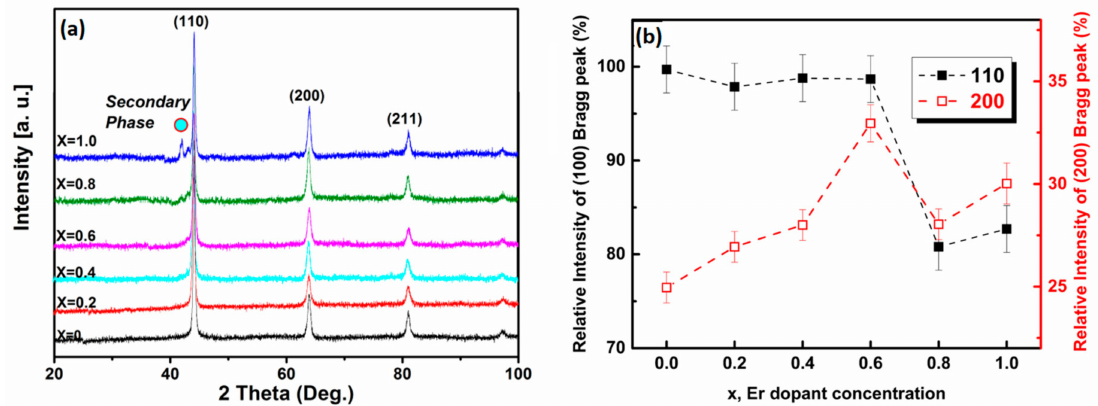
Figure 1. ( a ) X-ray diffraction pattern of directional solidified bulk alloys of Fe 83 Ga 17 Er x (0 < x < 1). An additional Bragg peak corresponding to a minor secondary phase is observed in samples where the Er dopant concentration ( x ) is higher than 0.6; ( b ) dependence of the relative intensity of the Bragg peaks corresponding to (110) and (200) planes on Er content ( x